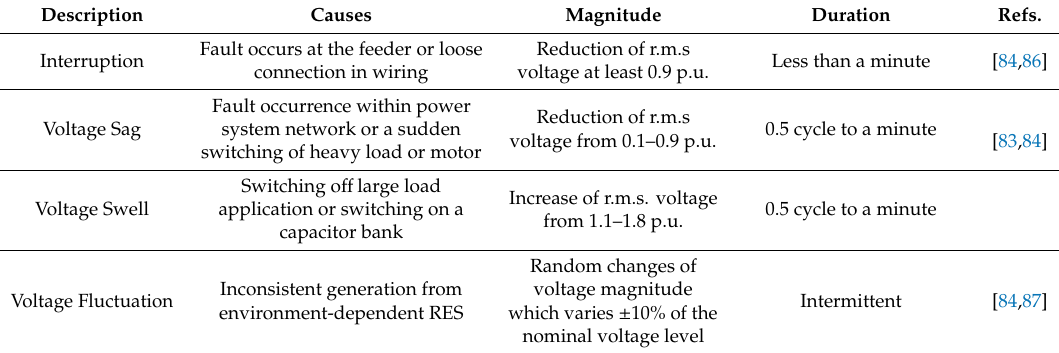
Table 2. Summarization of voltage disturbance issues on voltage interruption, fluctuation, sag, and